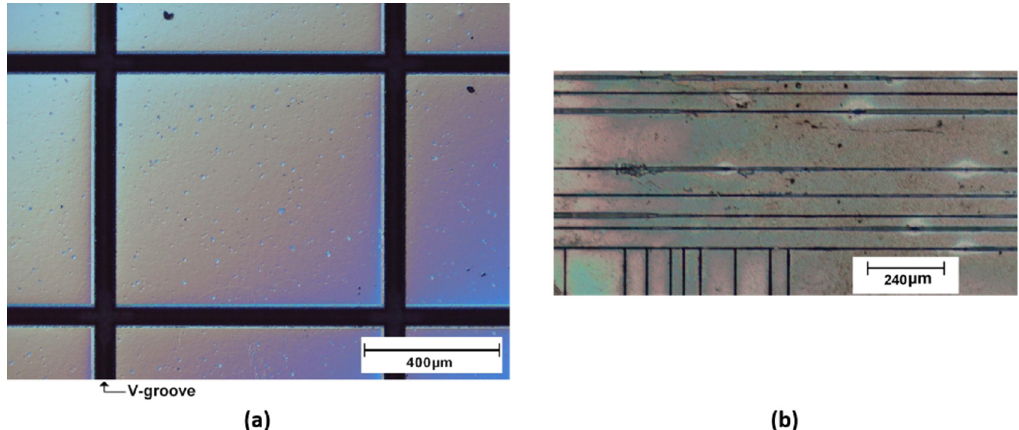
Figure 18. Nomarski optical micrograph of the etched surface morphologies of GaAs / Si sample ( a ) with and ( b ) without mid-patterned growth. Reprinted with permission from Reference [239] © 2008 American Institute of Physics.